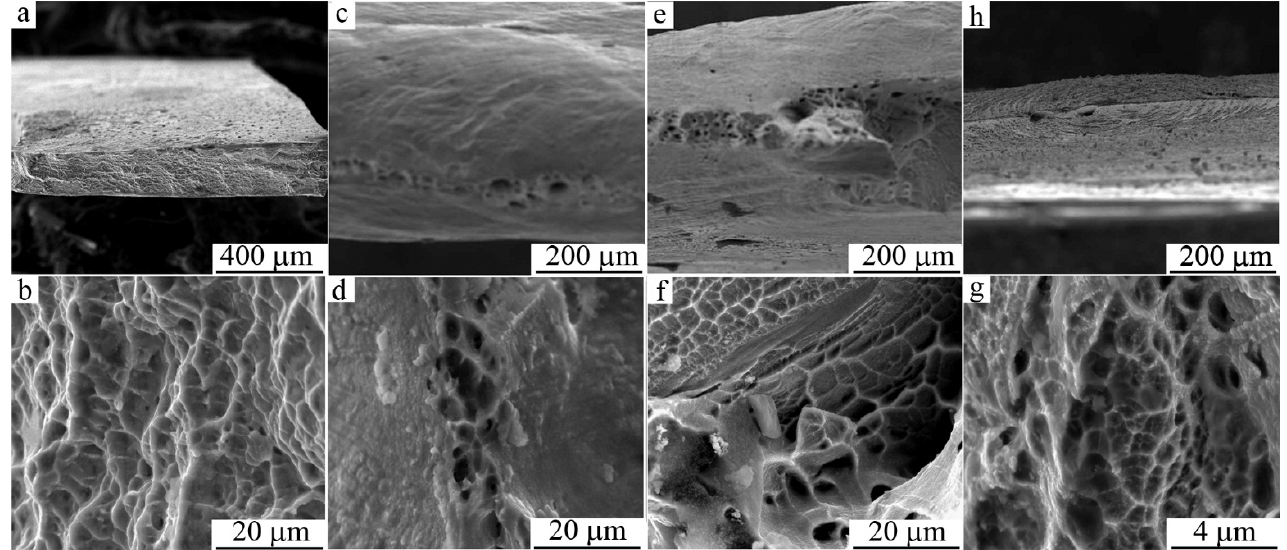
Figure 34. SEM images (different magnifications) of fracture surfaces of the Cu–14Al–3Ni alloy after tension at v = 10 –4 1/s and various temperatures: ( a , b ) 423, ( c , d ) 473, ( e , f ) 573, and ( g , h ) 673 K [65].